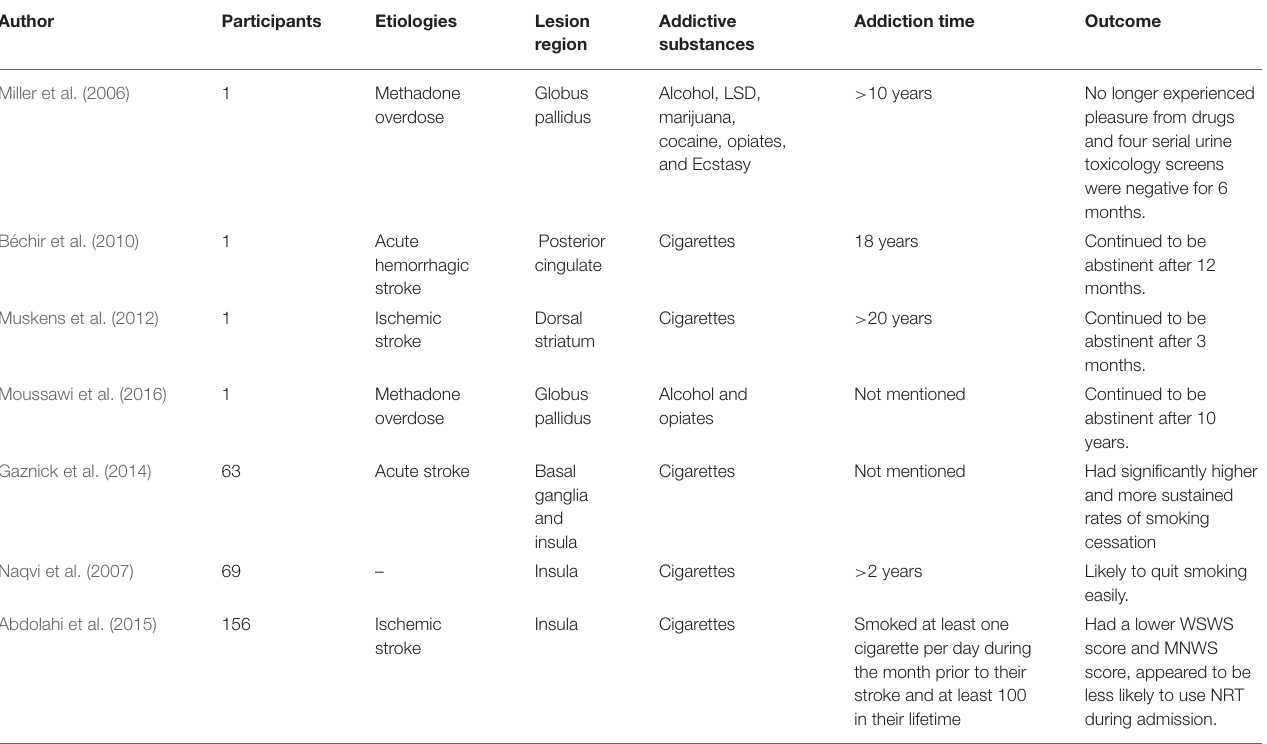
TABLE 4 | Some studies on the disruption of addiction after injury to different brain